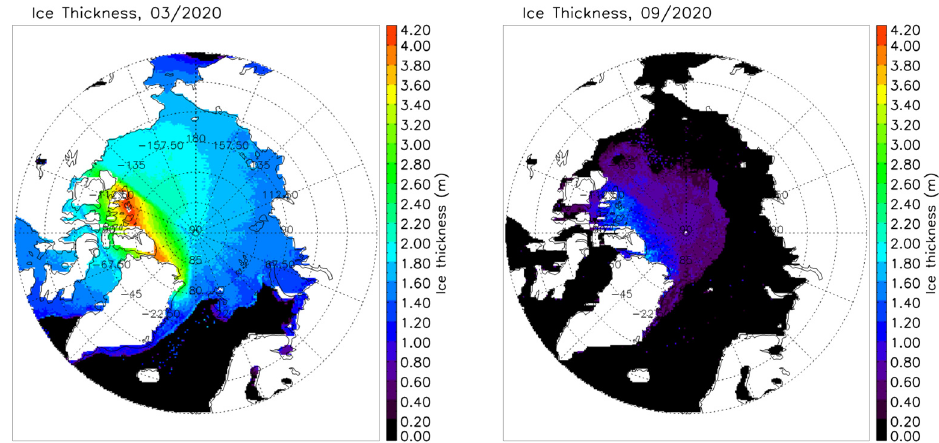
Figure 8. Spatial distributions of Arctic monthly mean SIT in March ( left ) and September ( right ) in 2020 from this study.